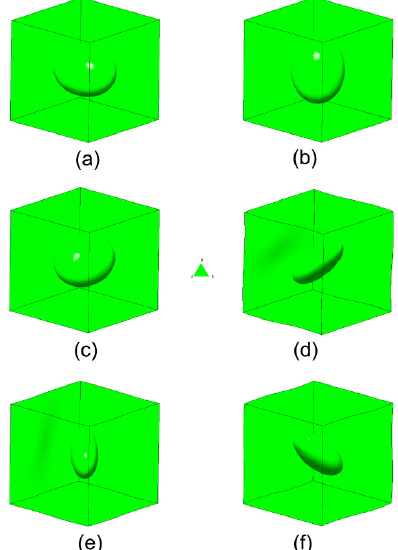
Figure 7. Characteristic deformations of solid cube with spherical void inclusion (0.05). ( a ) χ 11 ; ( b ) χ 22 ;